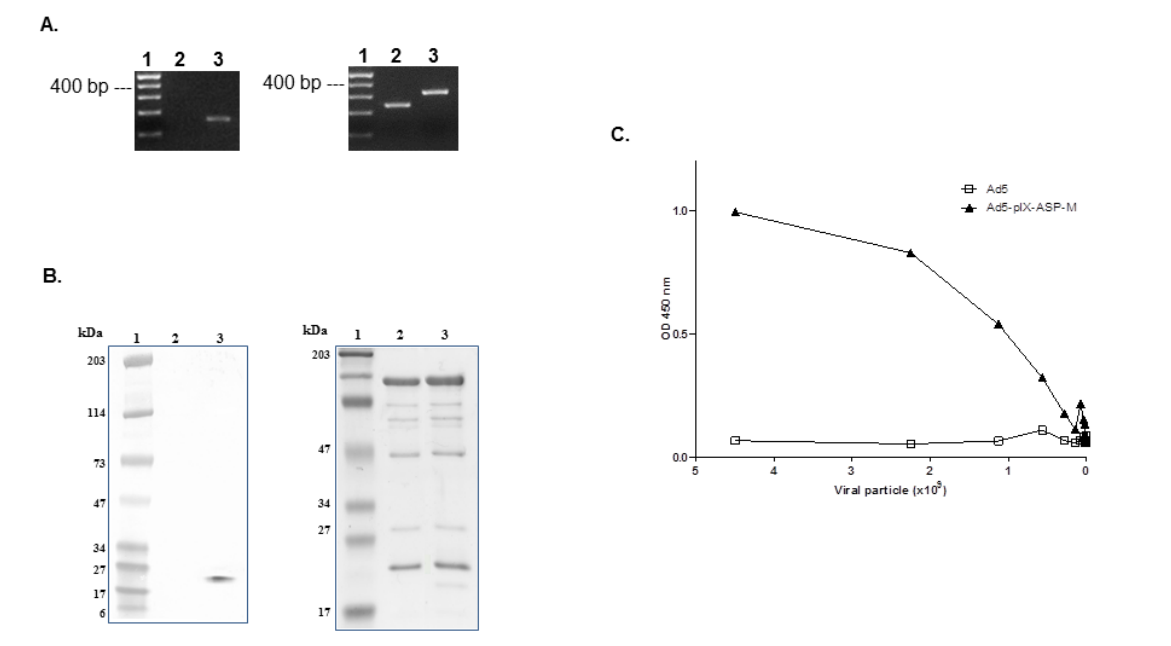
Figure 2. Verification of epitope capsid-incorporation into pIX of Ad5 (A and B) and epitope expo- sure on the virion surface (C). (A): left panel A, pIX-specific PCR primers confirmed the presence of the ASP-M DNA within the pIX locale. Lane 1, DNA ladder; lane 2, Ad5; and lane 3, Ad5-pIX-ASP-M. Right panel A, T. cruzi -His -specific primers confirmed the incorporation of ASP-M and His 6 1, DNA ladder; lane 2, Ad5; and lane 3, Ad5-pIX-ASP-M. (B): Left panel B, Immunoblots confirmed the presence of His incorporation within the modified vector. Protein marker (lane 1), Ad5 (lane 2), and 6 Ad5-pIX-ASP-M (lane 3). Right panel B, Coomassie blue staining of the Ad5 vectors. Protein marker (lane 1), Ad5 (lane 2), and Ad5-pIX-ASP-M (lane 3). (C): Varying amounts (starting at 4.5 × 10 9 VP/mouse) of Ad5 or Ad5-pIX-ASP-M were immobilized onto the wells of ELISA plates, incubated with His HRP-conjugated secondary antibody and the OD was read at 450